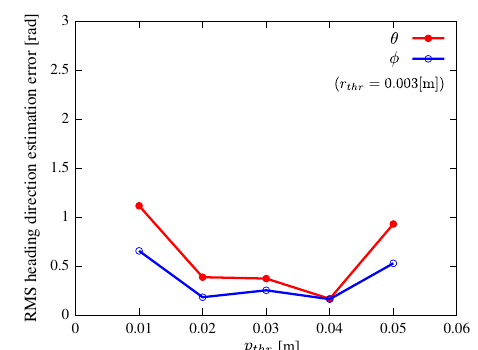
Figure 7: RMS heading direction estimation